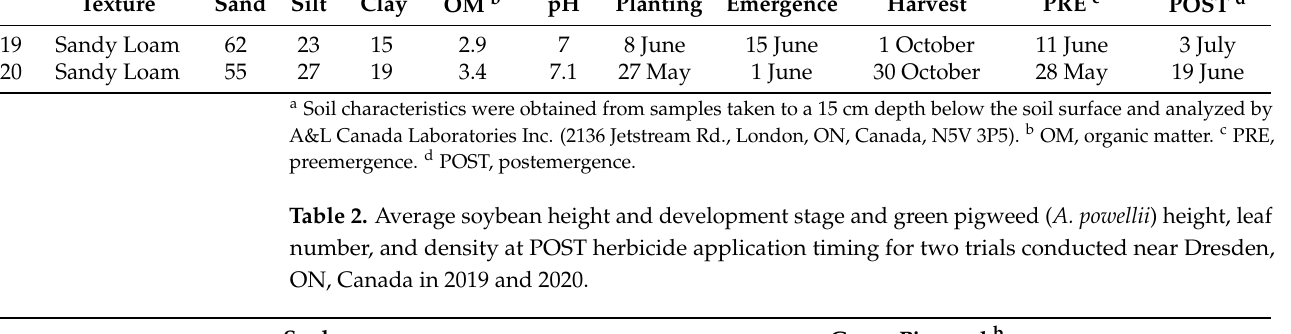
Table 1. Soil, soybean agronomic, and herbicide application information for four trials conducted near Dresden, ON, Canada in 2019 and 2020.